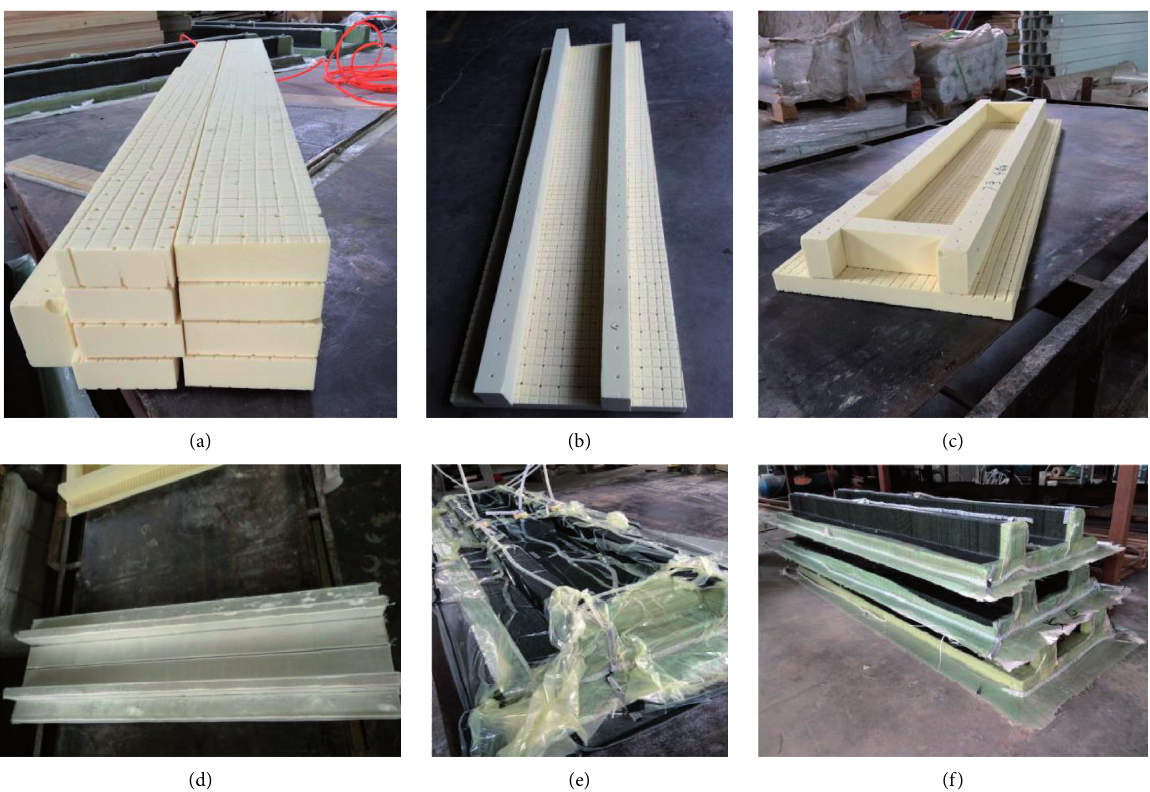
Figure 2: Fabrication procedure of test specimens: (a) the separation foams which have been grooved and drilled on the surface, (b) assembling foams of slab and ribs, (c) assembling diaphragms, (d) wrapping the assembled foams with GFRP, and (e, f) vacuum-assisted resin infusion process.